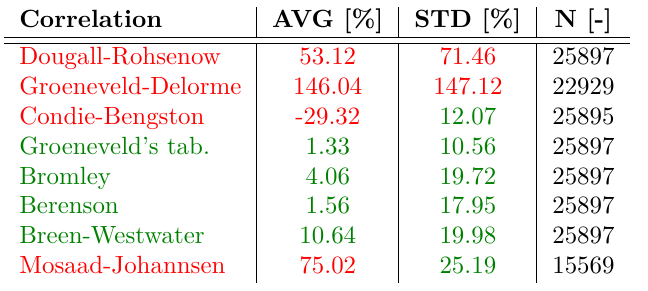
Table 4. Overall statistic analysis of correlations compared with Stewart’s experimental data.